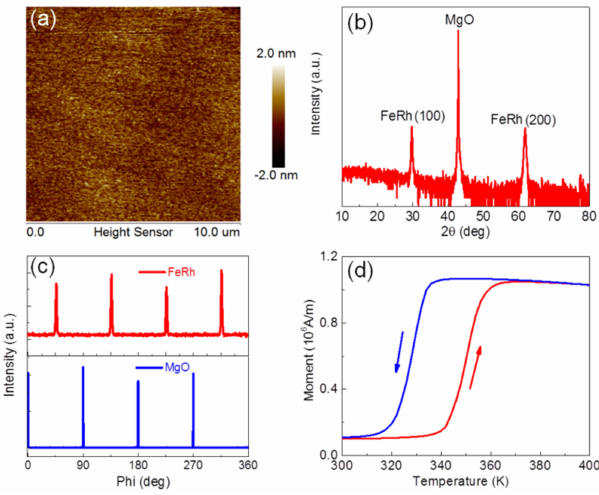
Figure 1. ( a ) The AFM image of the FeRh films. ( b ) θ -2 θ scan and ( c ) ϕ -scans of FeRh/MgO. ( d ) The temperature-dependent magnetization of the FeRh film measured with an in-plane magnetic field